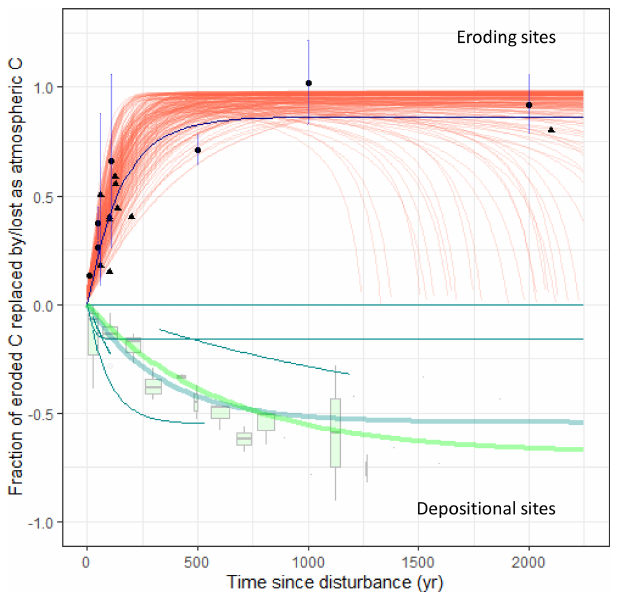
Figure 3. Fraction of eroded OC replaced by atmospheric CO 2 as a function of time since the start of agricultural erosion at eroding sites (upper part) and depositional sites (lower part). For the erod- ing sites, studies using mass balance (circles) and models (trian- gle) are considered. The error bars denote the reported uncertainty range. The bold blue line denotes a fit of a non-linear regression model through the reported soil OC recovery data points. The fine red lines represent the results of 100 model runs covering a range of typical erosion and OC turnover rates representative of global agri- cultural land. We use the model for cropland presented by Quinton et al. (2010). Erosion rates were allowed to vary randomly between 0.1 and 0.2mmyr − 1 , and soil OC residence time for the top layer varied between 200 and 1000 years. For the feedback scenario, we assumed negative feedback that ranged randomly between 3% and 5% yield loss for each 10cm of cumulative erosion (Bakker et al., 2004). The green boxplots represent oxidation in colluvial settings ( n = 255; see Table 2). The thin cyan lines represent the non-linear regression models for five alluvial studies ( n = 273; see Table 2). The thick green and cyan lines represent the response curves for colluvial and alluvial burial using the median values for α and τ